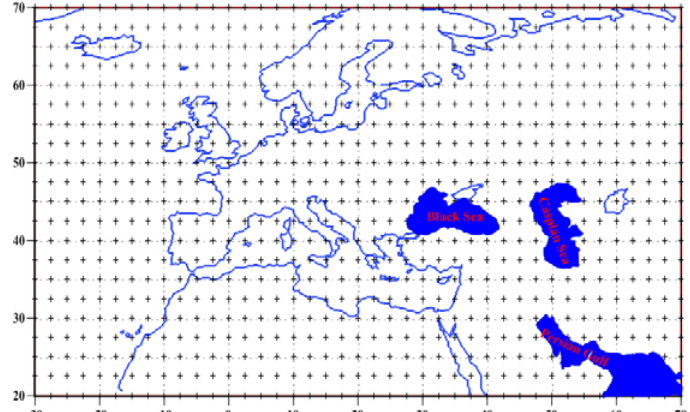
Fig. 1. Position of Investigated Zone with 861 Pixel and Spatial Resolution 2.5×2.5